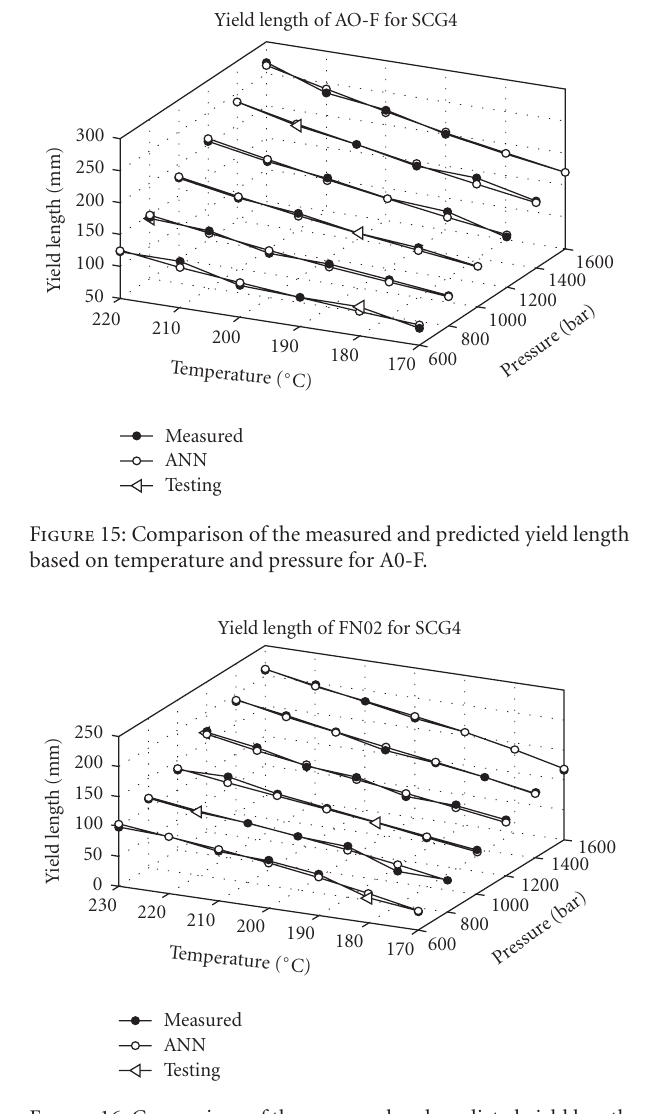
Figure 16: Comparison of the measured and predicted yield length based on temperature and pressure for